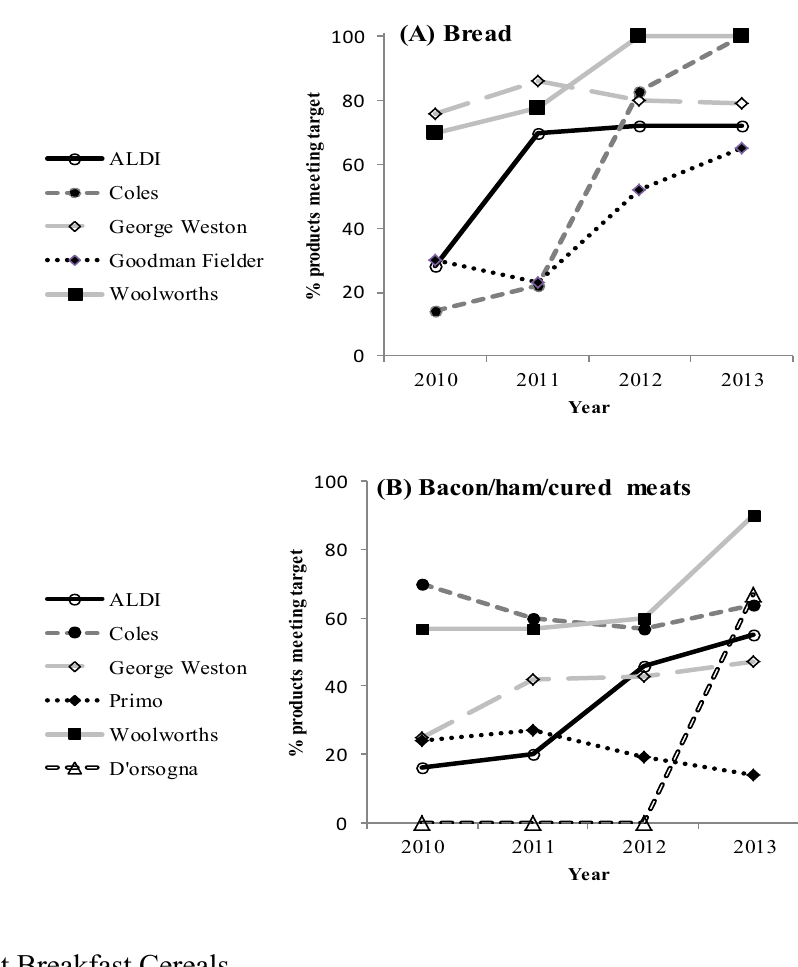
Figure 2. Proportion of products that met the respective Food and Health Dialogue (FHD) target by food companies participating in FHD from 2010 to 2013 for ( A ) bread, ( B ) bacon/ham/cured